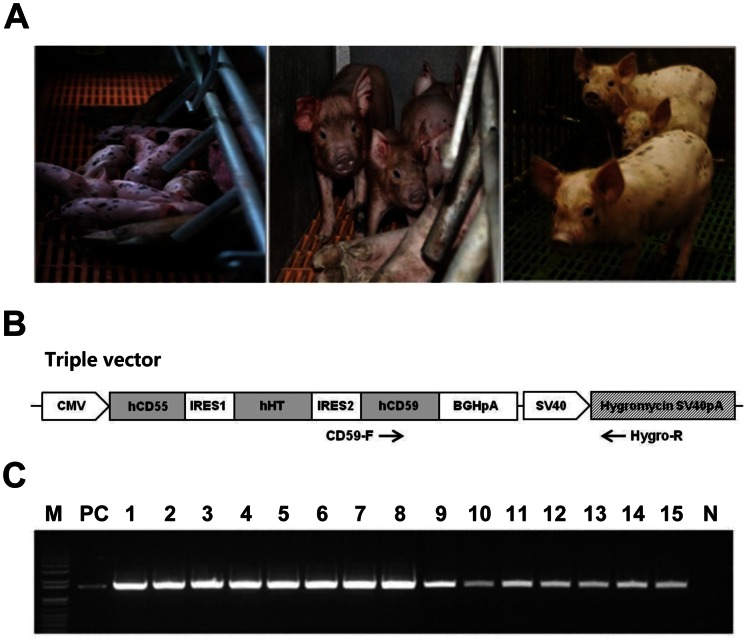
Production of transgenic pigs coexpressing hCD55, hCD59, and HT.(A) human CD55, CD59, and HT-transgenic piglets produced by SCNT. Left panel: female clones, middle and right panel: male reclones (B) Two different primer sets were used to genotype for the transgene. (C) M, size marker; PC, Triple plasmid vector as a positive control; 1–15 triple-transgenic piglets; N, non-transgenic pigs as a negative control.